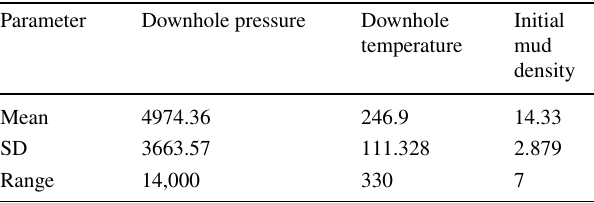
Table 3 Process input and output parameters of mud density and their values